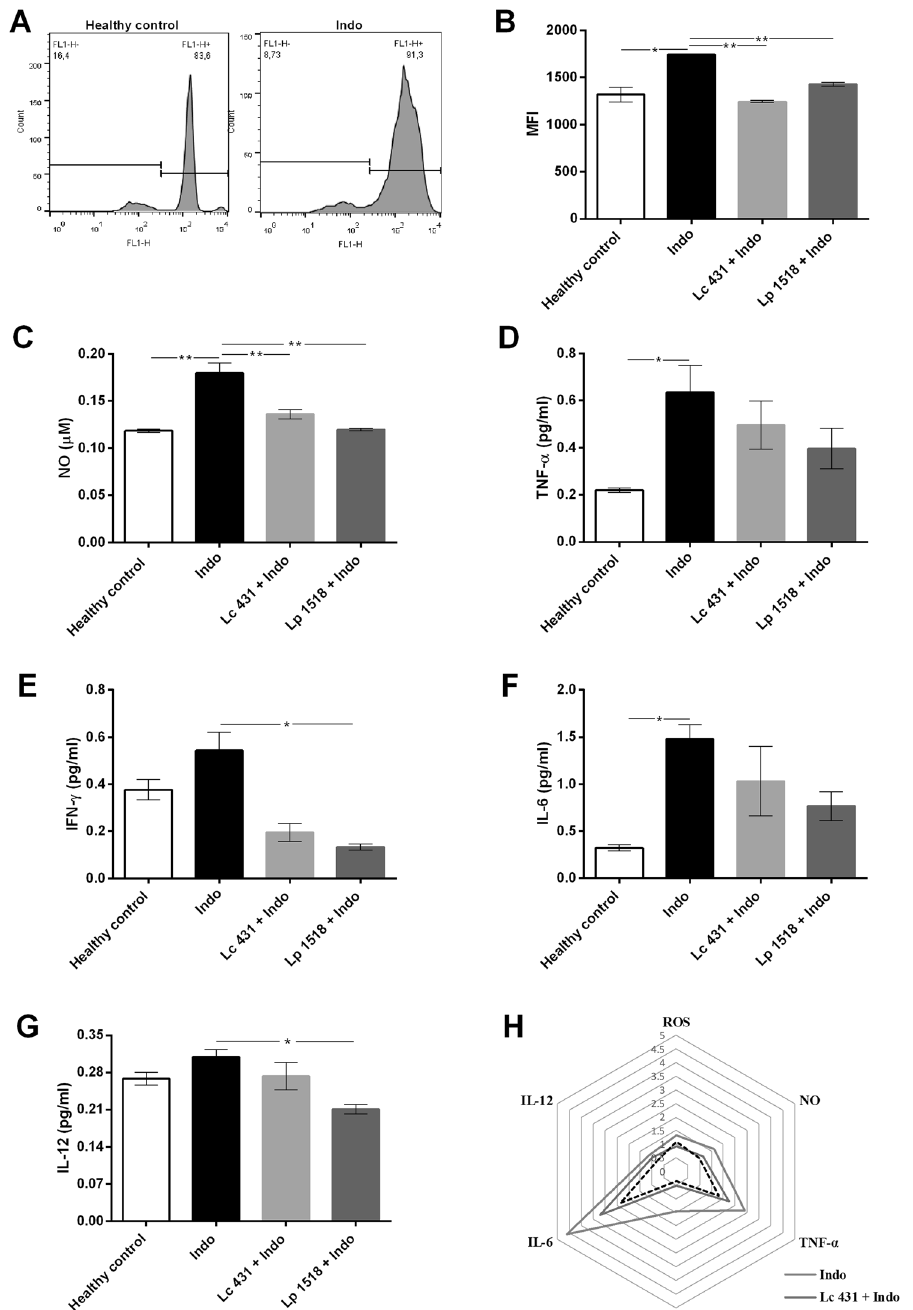
Figure 7. Release of reactive oxygen species and cytokine mediators of intestinal inflammation by macrophages. Balb/c mice supplemented with L. casei CRL 431 (Lc 431), L. paracasei CNCM I-1518 (Lp 1518), or water, for 7 and 5 days, received indomethacin injections on the last two days. On day 8, mice were euthanized and samples of peritoneal macrophages were taken. ROS production as fluorescence units of oxidized dichlorodihydrofluorescein was detected by flow cytometry and ( A ) representative histograms and ( B ) mean fluorescence intensity (MFI) in experimental animals were shown. Peritoneal macrophages were incubated at 37 °C 5% CO 2 for 16 h and the supernatant collected for the determination of: ( C ) NO by Griess reagent; ( D , E , F , G) proinflammatory cytokines by Capture ELISA. Results are expressed as mean ± SEM and are representative of at least three independent experiments. The line at the top of the bars indicates comparison between the 2 groups. * p < 0.05 and ** p < 0.01. ( H ) Radar chart plot of inflammatory mediators released by macrophages from the different experimental groups. Results are expressed as the ratio between each group and the healthy control